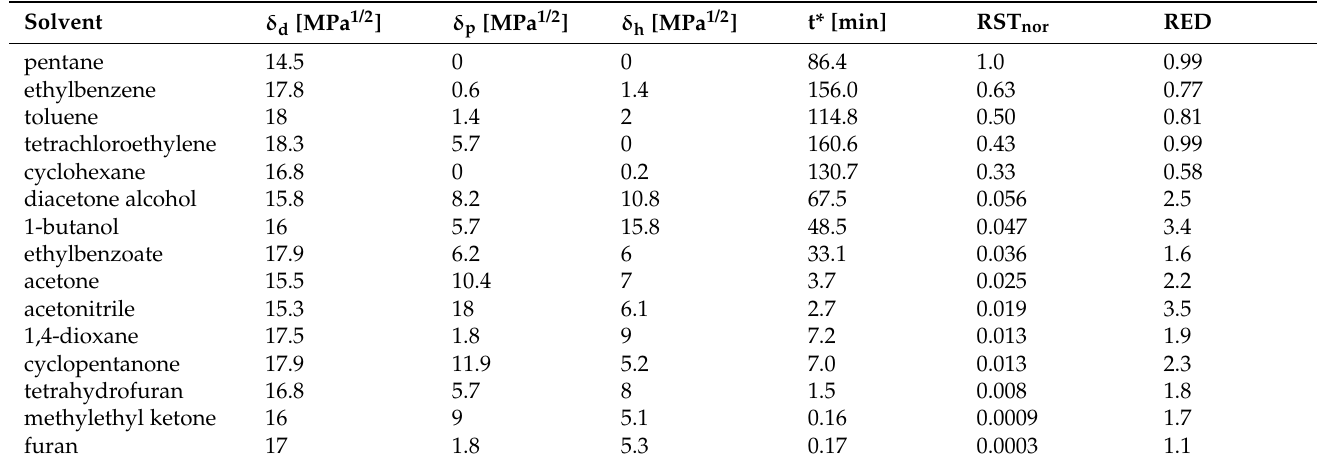
Table 1. Solubility parameters (MPa 1/2 ) and computed RST nor and RED values for solvents used in the study for the determination of